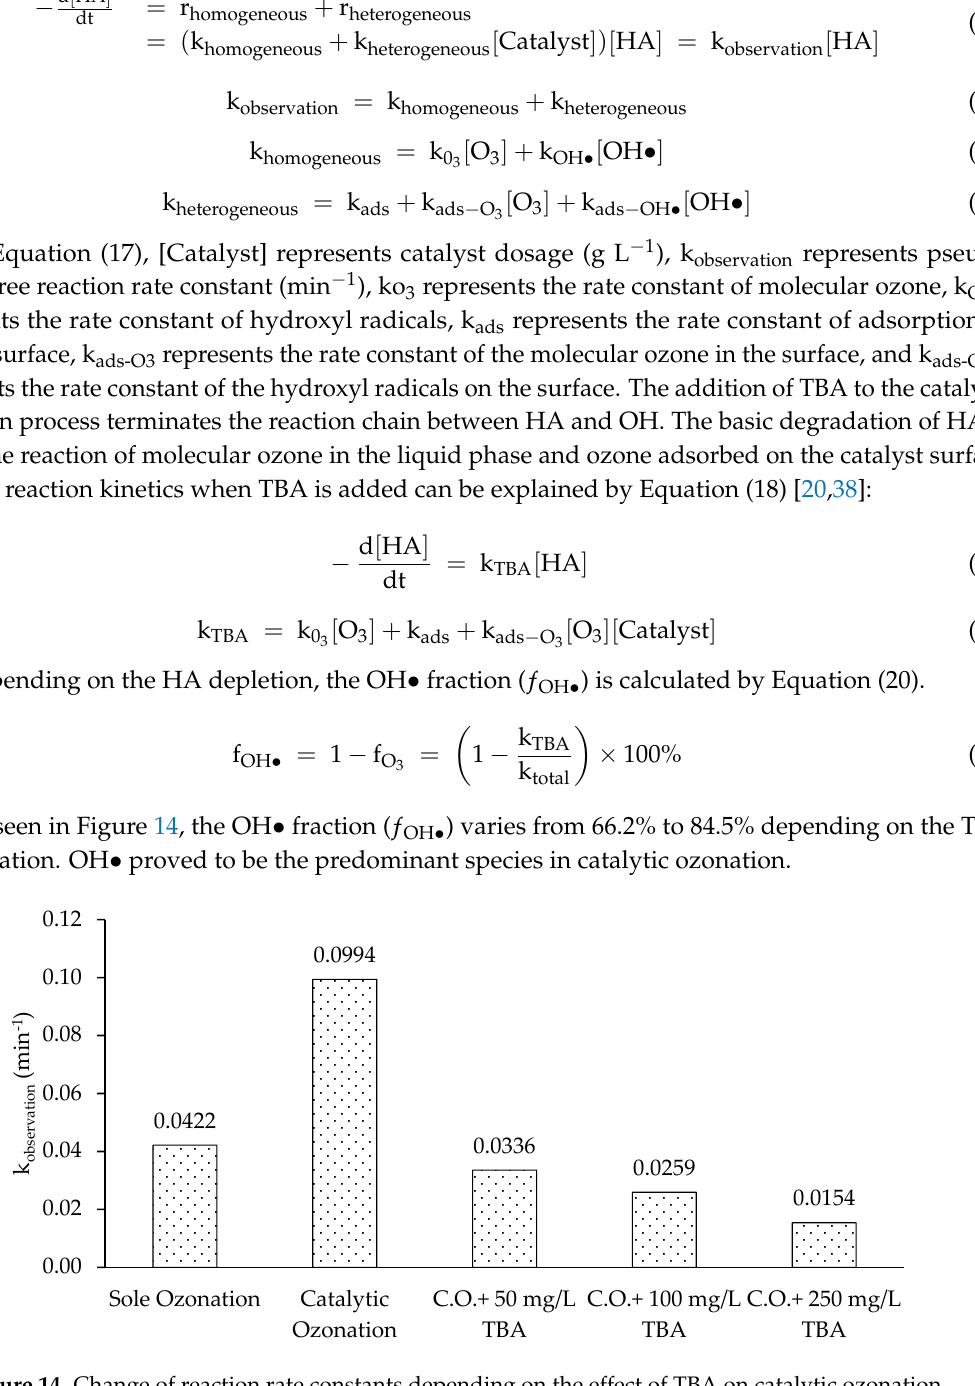
Figure 14. Change of reaction rate constants depending on the effect of TBA on catalytic ozonation.